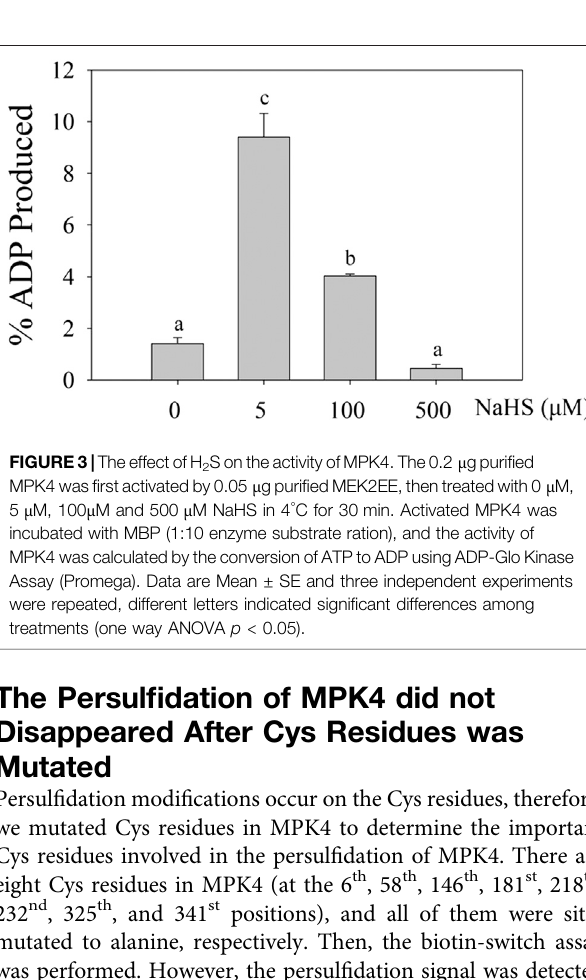
Frontiers in Molecular Biosciences |